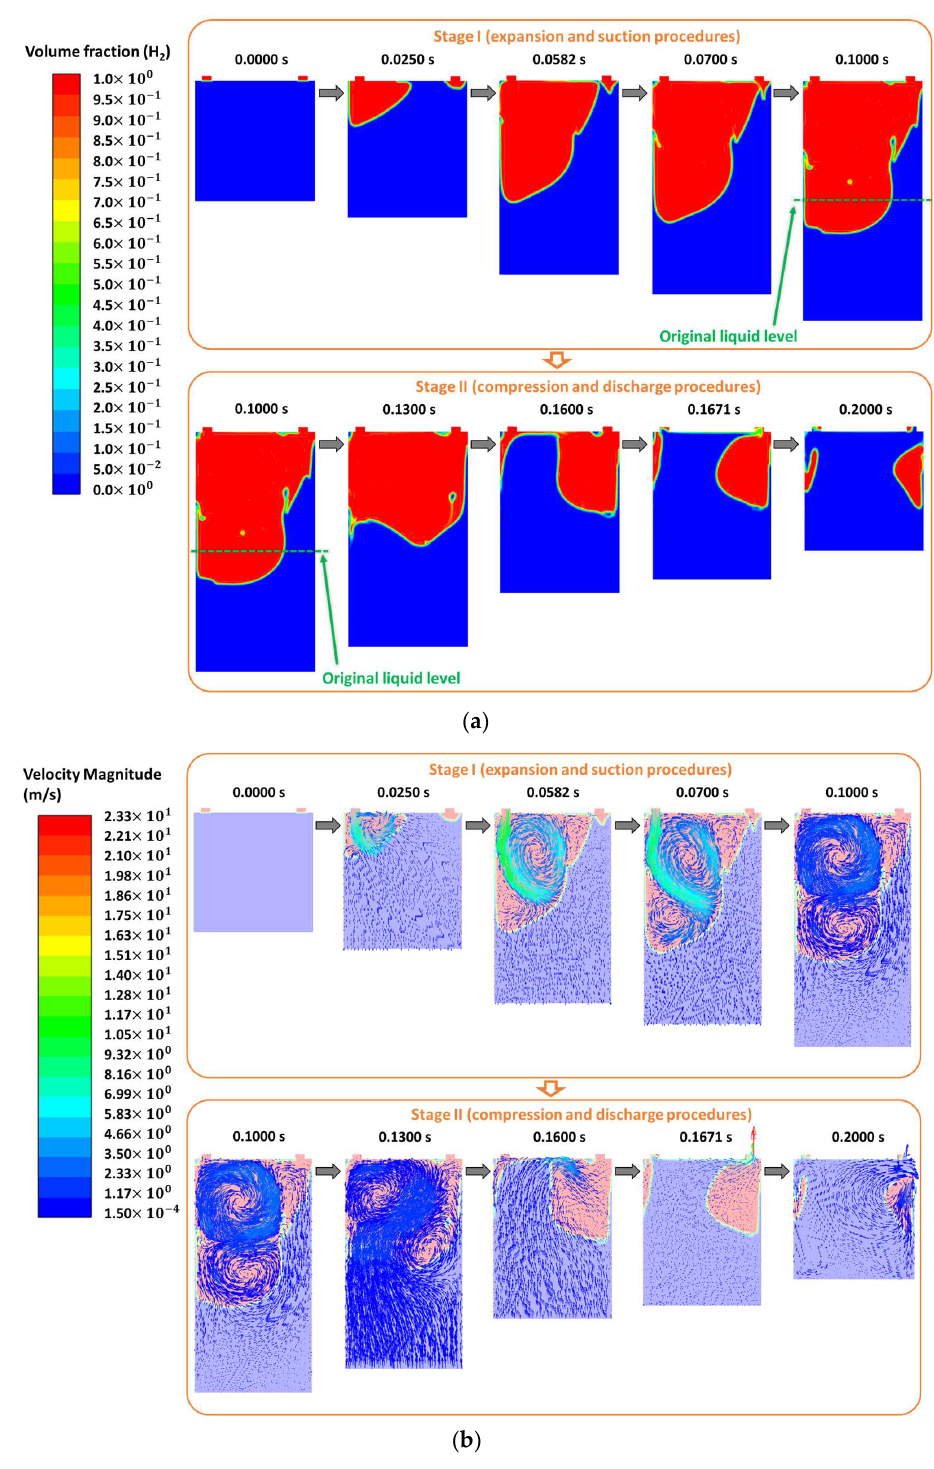
Figure 5. Results of the ( a ) volume fraction field and ( b ) velocity field (density of the ionic liquid: 1150 kg/m 3 ).